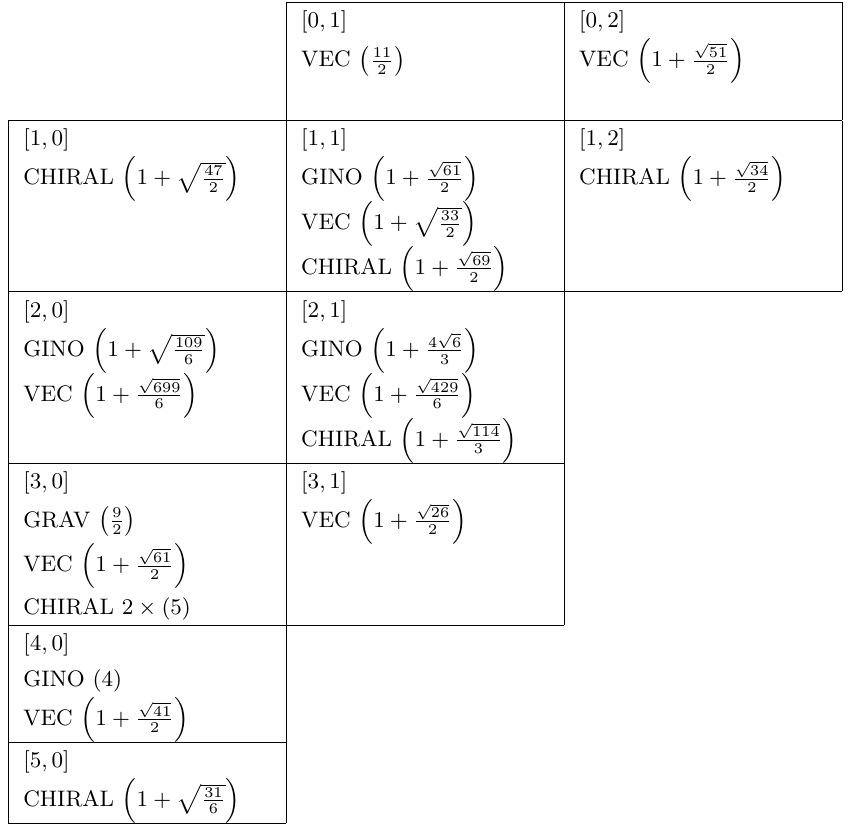
At KK level n = 0 , the spectrum of the G